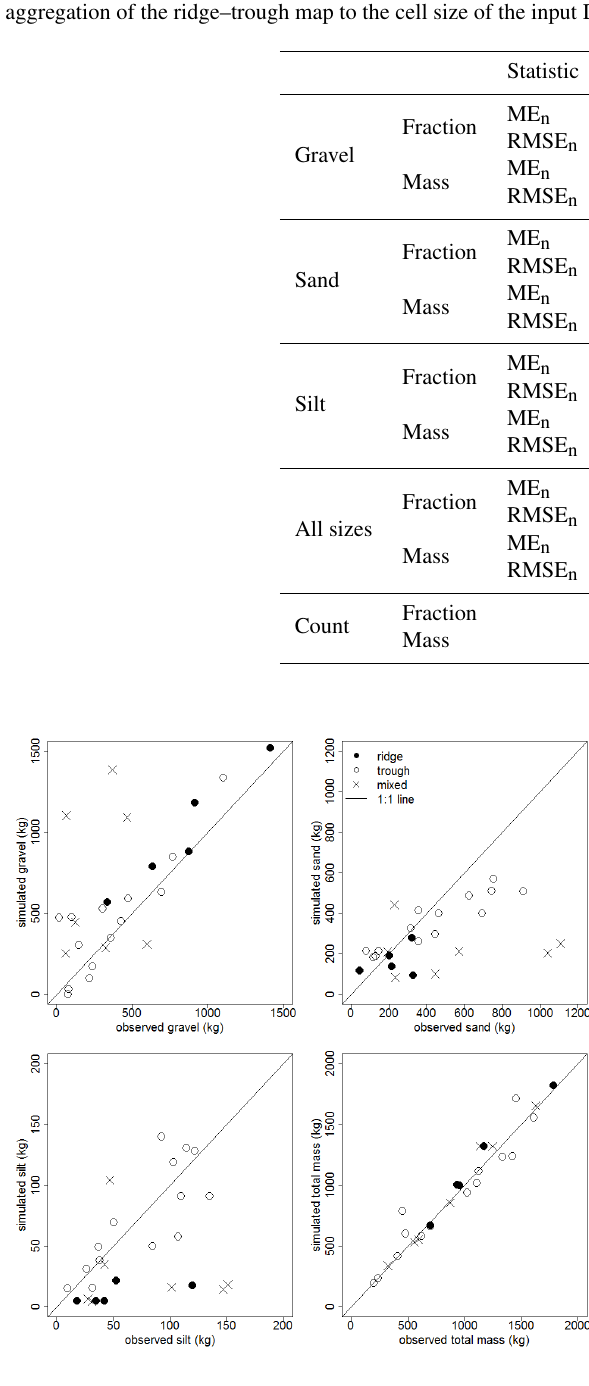
Figure 8. Scatter plots of simulated versus observed mass in kilo- grams over the total observed depth, for different particle sizes and morphological positions. The black line indicates the 1:1 line, which indicates a perfect match between model and field